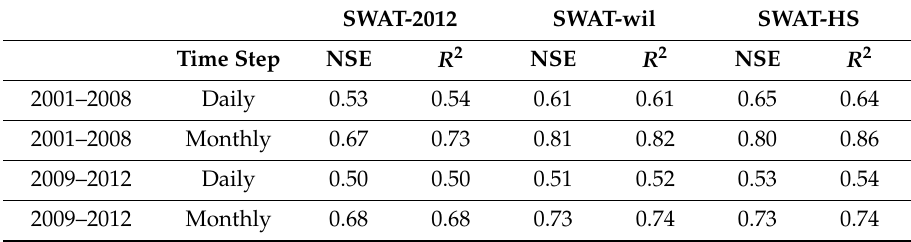
Table 4. Mean daily discharge and stormflow components for 2001–2012 by different SWAT models.